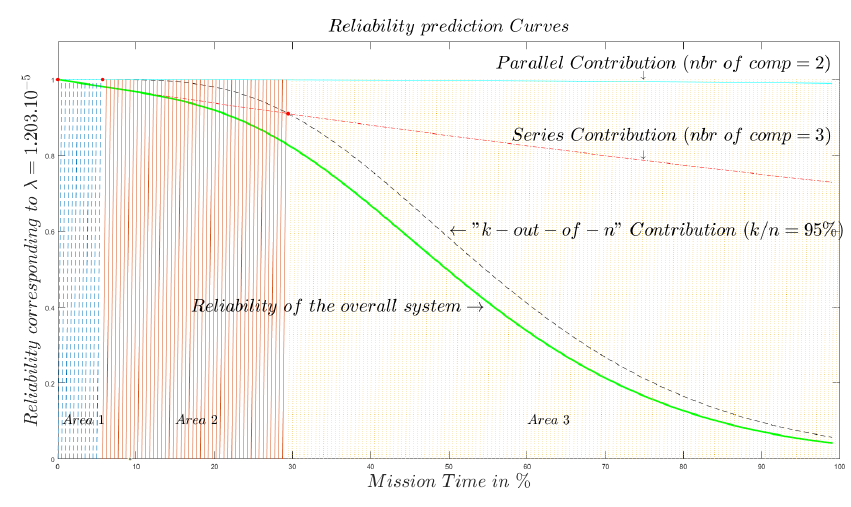
Figure 16. Reliability behavior of an End-to-End IoT system with k / n = 95%.